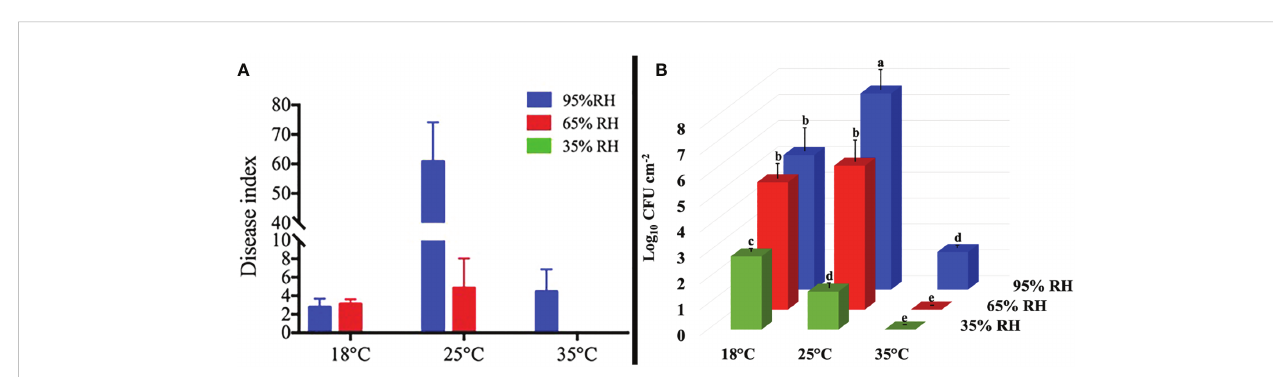
FIGURE 5 Effect of temperature and relative humidity (RH) on the pathogenicity and colonization of Pseudomonas amygdali pv. lachrymans (Pal ) in aerosols on cucumber leaves. Healthy cucumber plant were exposed to Pal ::GFP aerosol, generated by a six-jet Collison nebulizer for 30 min at the fl ow rate of 12 L/min, in chambers at different levels of temperature and RH. (A) The disease index and (B) colonization of Pal ::GFP in cucumbers leaves were measured at 7 days after exposed to Pal ::GFP aerosols at different levels of temperature and RH. The experiments were independently repeated three times. Columns and error bars represent the mean values and standard deviations (SDs) of three replicates. Columns labeled with different letters indicate statistically signi fi cant differences ( p < 0.05).